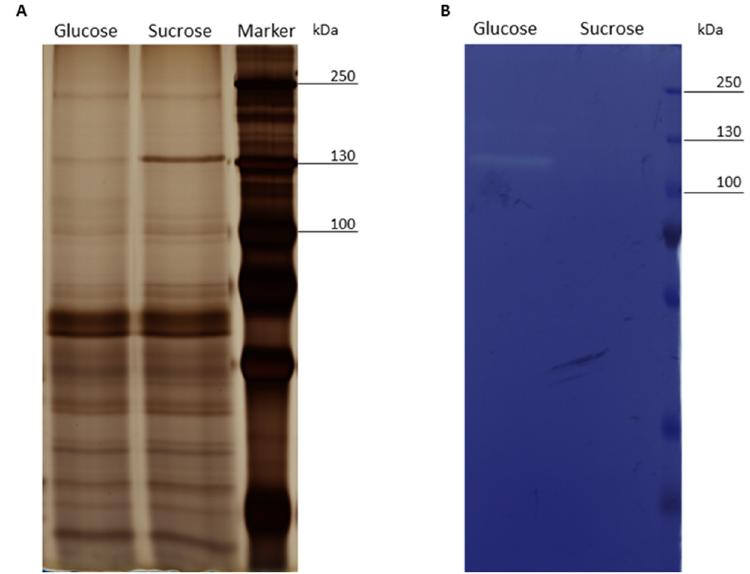
Figure 5. SDS-PAGE analysis of culture supernatants of cells incubated in either glucose or sucrose with subsequent silver staining ( A ) and zymogram analysis for the detection of lytic enzymes on gels containing dead cells of M. luteus TMW 2.96 ( B ).